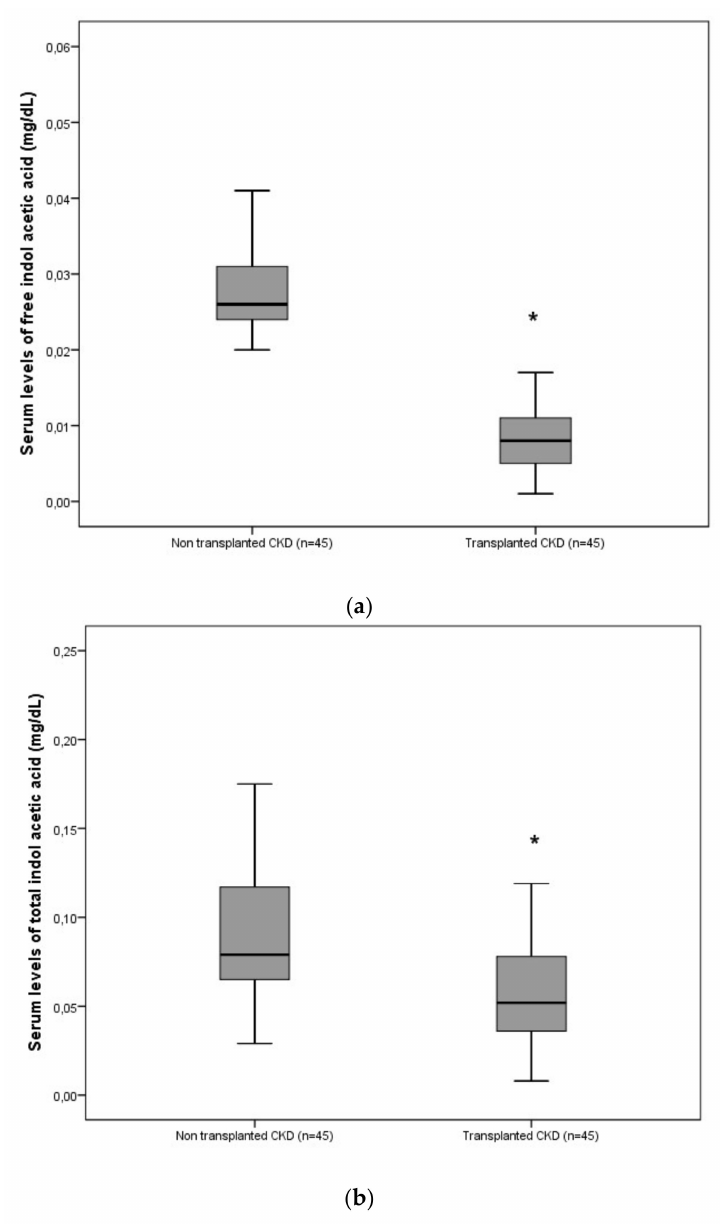
Figure 3. Comparison of mean (range) serum free ( a ) and total ( b ) indole-3-acetic acid (IAA) levels in non-dialized non-transplanted patients with CKD and in transplant recipients at month one (36.0 ± 10.4 mL / mi, / 1.73 m 2 ) matched for age, sex and estimated glomerular filtration rate (eGFR). ( a ) * p < 0.0001; ( b ) * p = 0.02. Boxplot with whiskers with maximum 1.5 interquartile